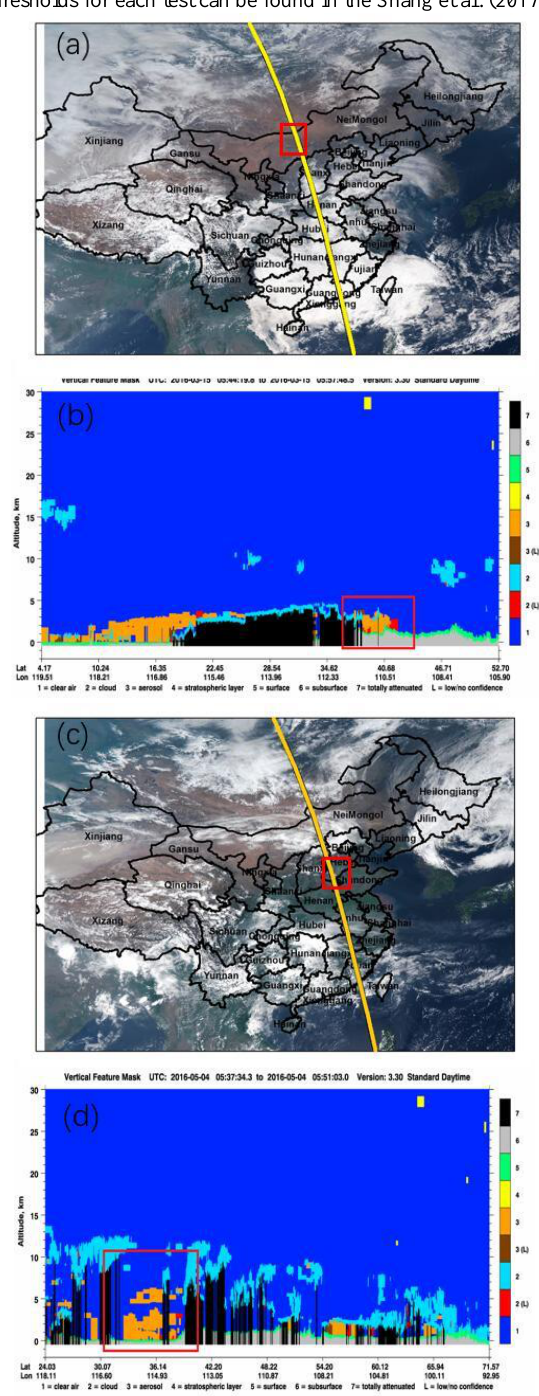
Figure 1 The true color image (a) and VFM (b) for 15 March 2016; the true color image (c) and VFM (d) for4 May 2016. The CALIPSO orbit are shown in yellow line, the red box indicates the sampling region for dust storm in these two